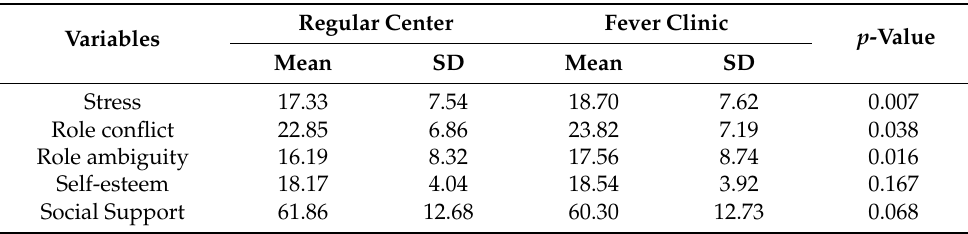
Table 4. T-tests and Descriptive Statistics for Stress, Conflict, Ambiguity, Self-esteem and